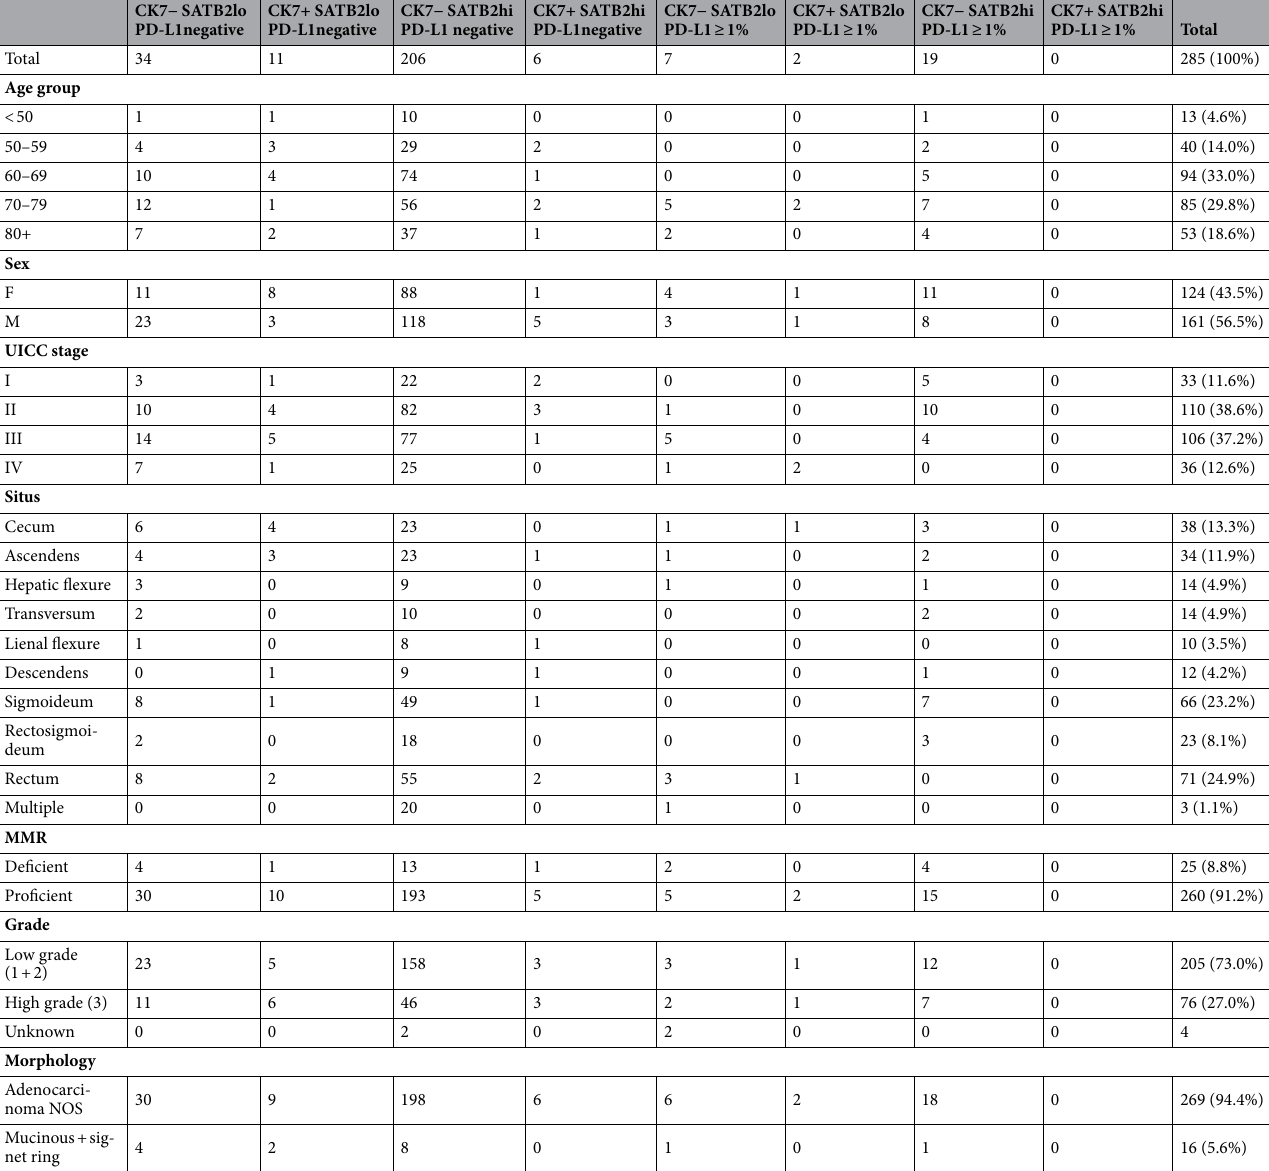
Table 1. Entire cohort. Summary of all cases and all examined variables, and the number of subjects according to their CK7/SATB2/PD-L1